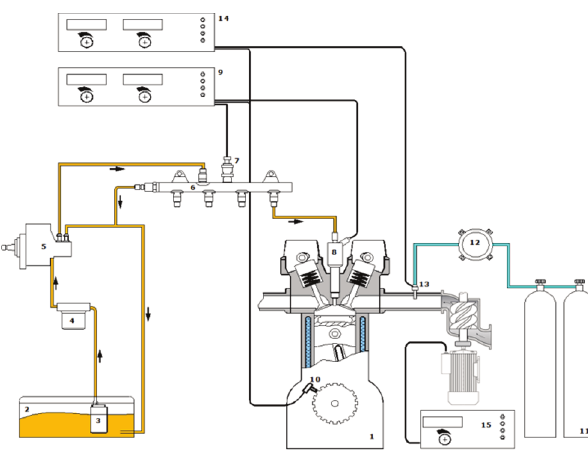
Fig. 1. General layout of dual-fuel system of CI engine supply: 1) dual-fuel engine, 2) diesel fuel tank, 3) electric fuel pump, 4) fuel filter, 5) high- pressure fuel pump, 6) hopper, 7) fuel pressure sensor, 8) diesel fuel injector, 9) controller of common rail supply system, 10) crank shaft location and speed sensor, 11) gas container, 12) pressure regulator, 13) gas injector, 14) controller of gas supply system; 15) engine charging